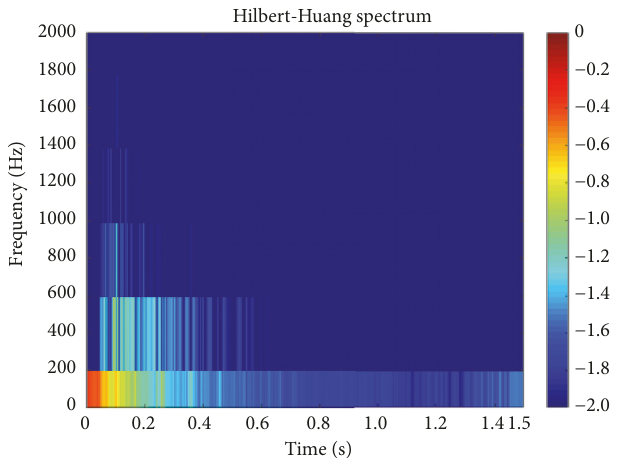
Figure 11: Frequency spectrum of vibration velocity signal at outer